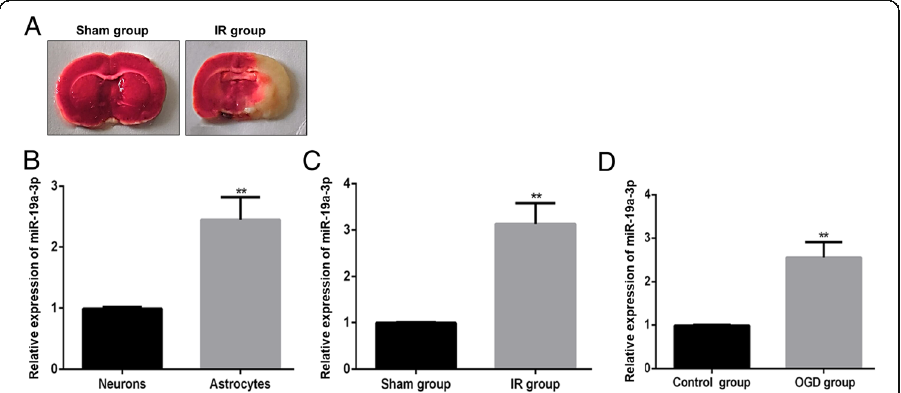
Fig. 1 Level of miR-19a-3p in astrocytes or neurons, and IR/OGD models. a , 2,3,5-triphenyltetrazolium chloride (TTC) staining of IR and sham groups to confirm successful ischemia induction. Representative images are shown. b , Difference in the expression level of miR-19a-3p in astrocytes and neurons. c , Difference in the expression level of miR-19a-3p in IR (astrocytes) model compared with sham group. d , Difference in the expression level of miR-19a-3p in OGD (neurons) model compared with control group. Results are representative of 3 independent biological replicates. IR and sham are from 5 animals each (** P